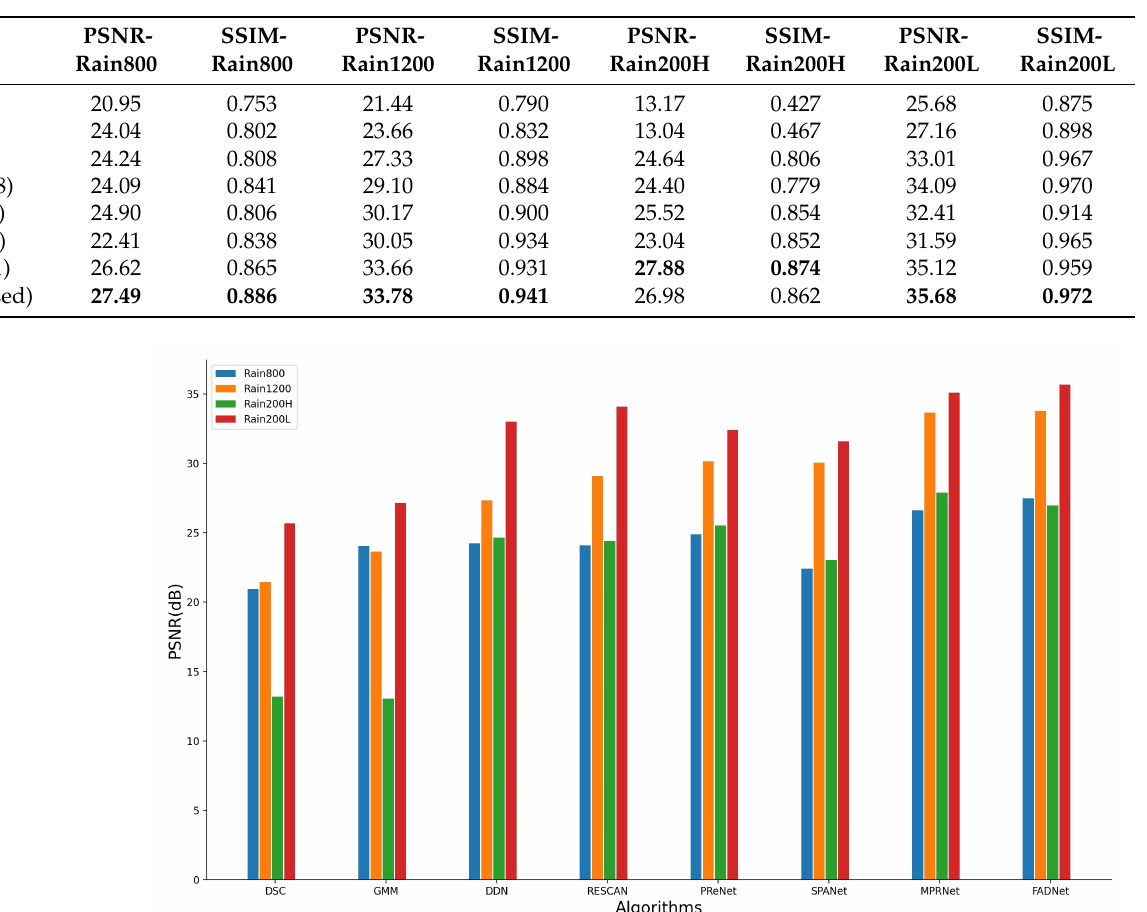
Table 4. Comparison of the quality of deraining in deraining data sets.